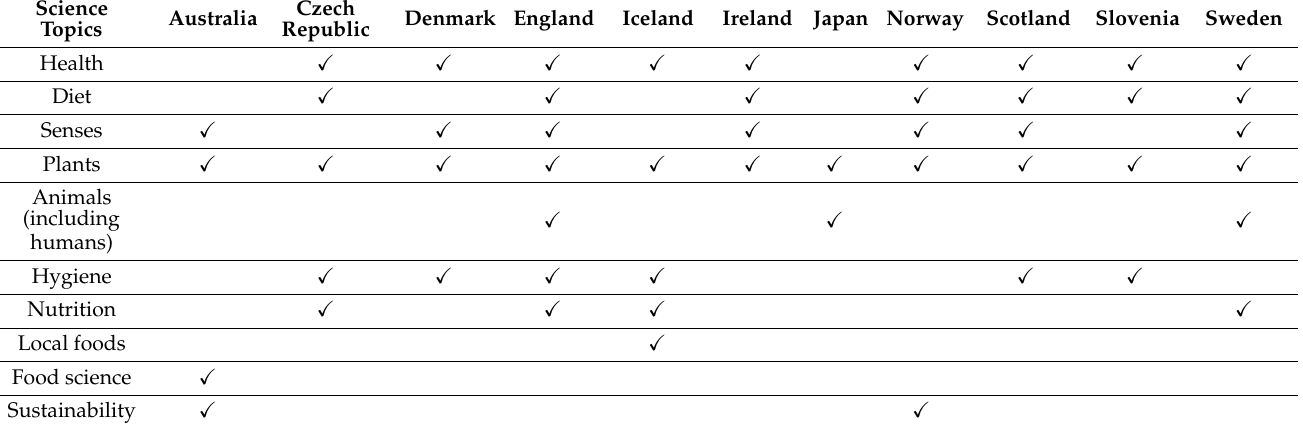
Table 5. Food education topics covered in science. Tick indicates country includes the topic within science. Source